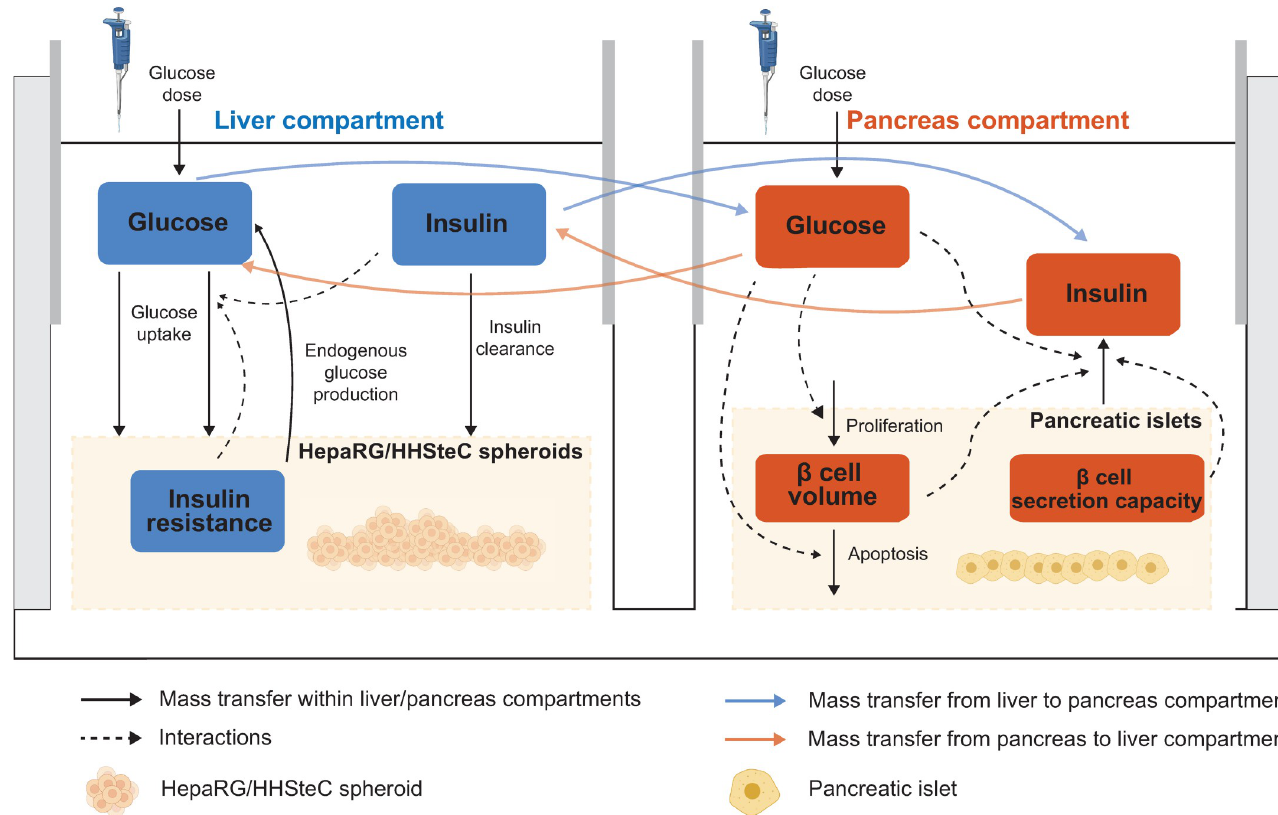
Fig 2. Graphical illustration of the computational model of the HepaRG liver-islet MPS. The physiological variables described by the model are displayed in blue and red text boxes. The solid arrows represent changes in these variables, mainly because of metabolic fluxes within each organoid compartment (black arrows) or between compartments (blue and orange arrows). Interactions between the variables are represented as dashed arrows.